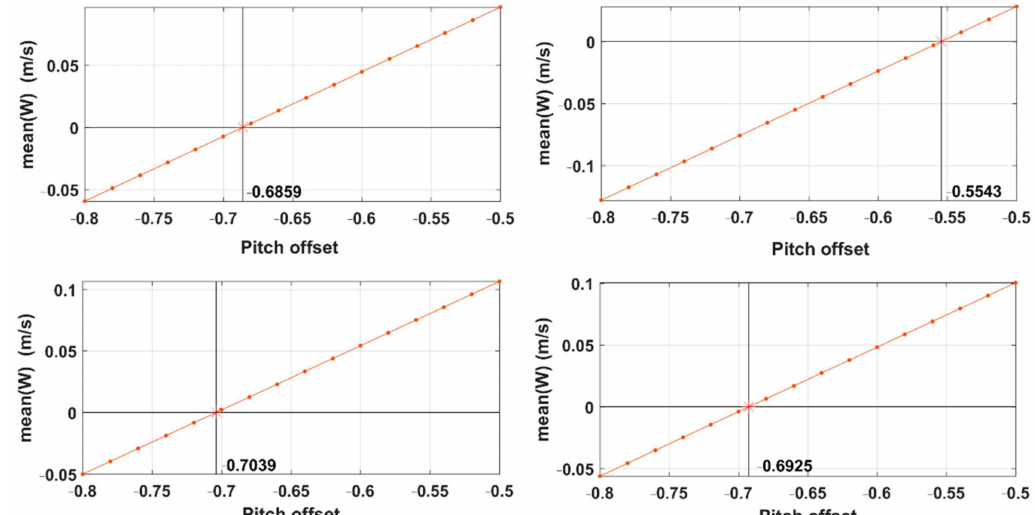
Figure 9. Results of determining the offset value of the pitch angle ( ε θ ) by finding the offset value that corresponded to the zero-averaged value of the vertical wind component ( w = 0). The final offset value of the pitch angle ( ε θ ) was calculated by averaging the determined offset value from the individual straight sections of the box maneuver.